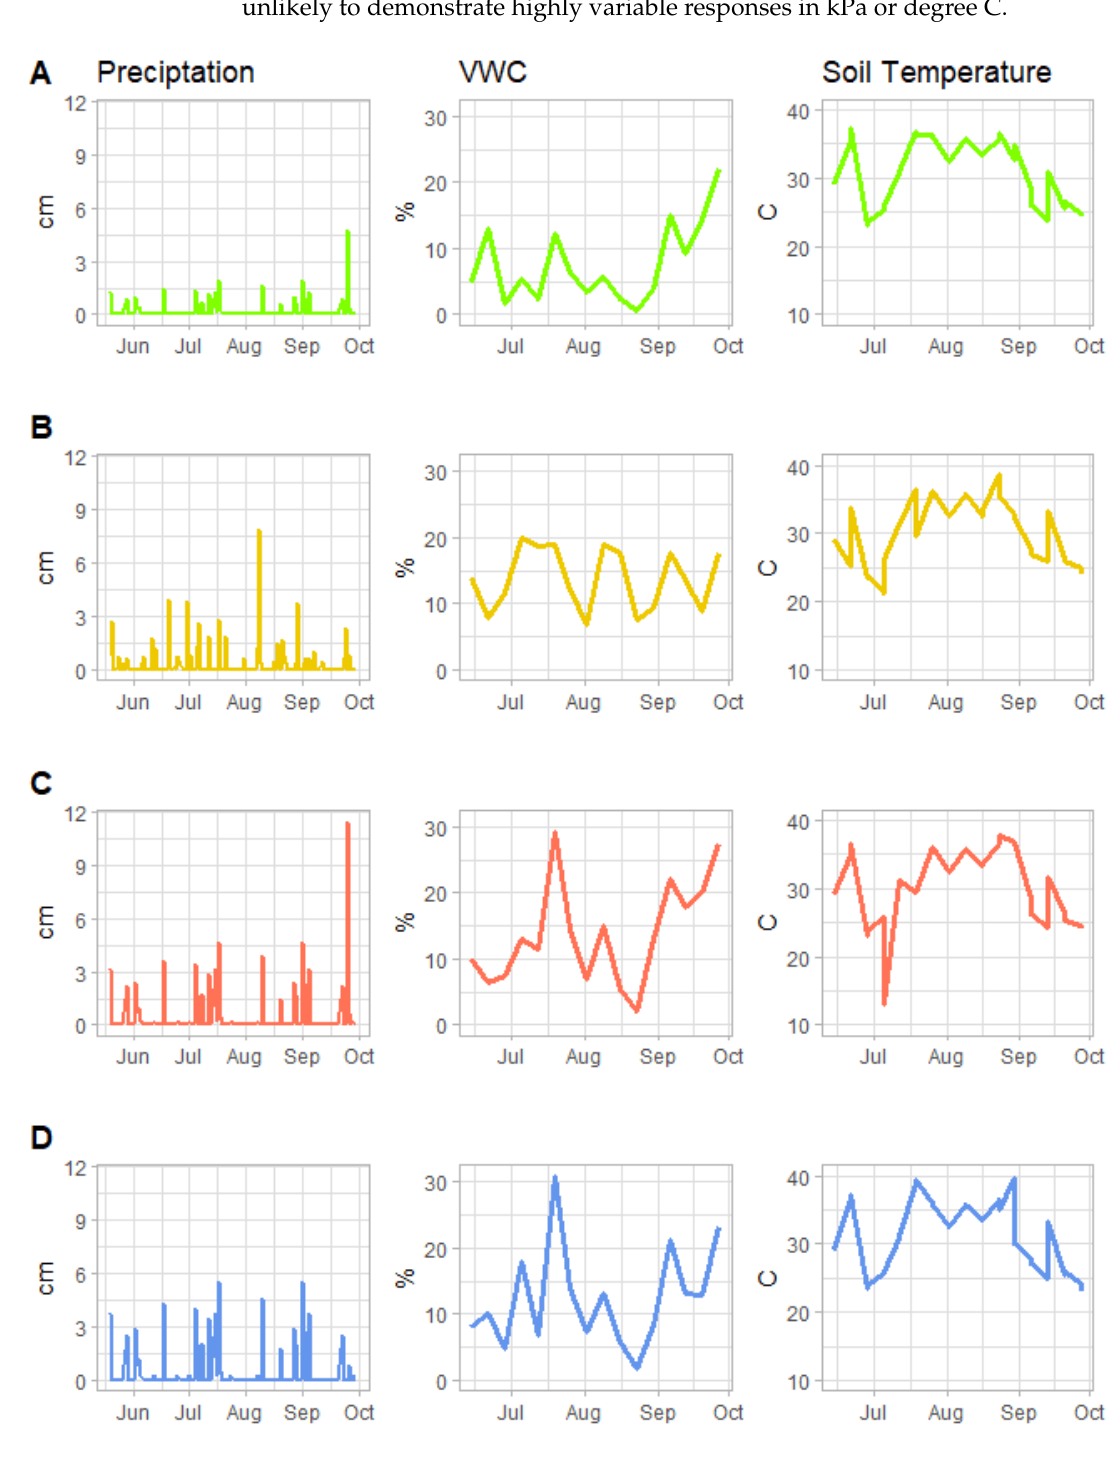
Figure 2. Recorded simulated precipitation (cm), soil volumetric water content (VWC, %) and soil temperature (degree Celsius) in each treatment: ( A ) = RECDry, ( B ) = RECWet, ( C ) = AMPDry1.43, ( D ) = AMPDry1.89. Note that VWC and soil temperature measurements did not commence until July